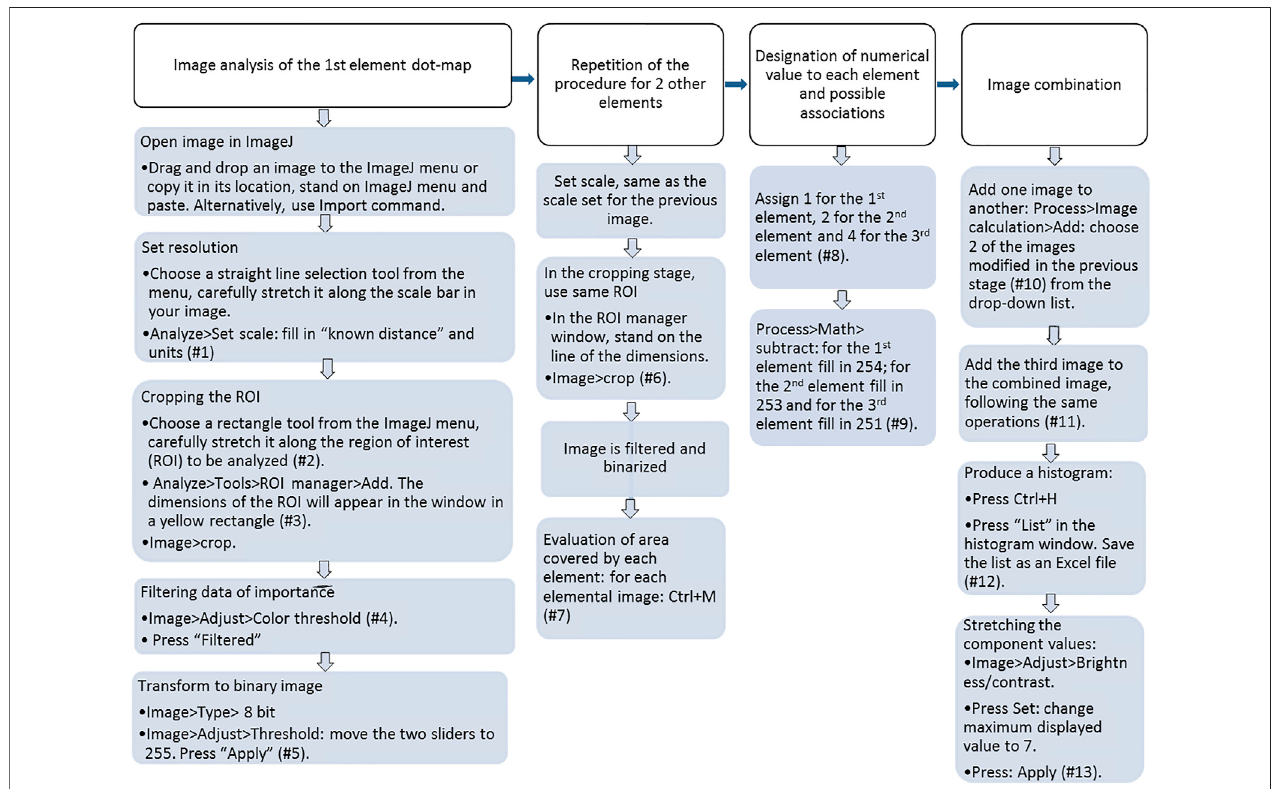
FIGURE 1 | Flow-chart diagram of the image analysis working procedure; demonstration of a system with three elements. Numbers refer to listed notes.